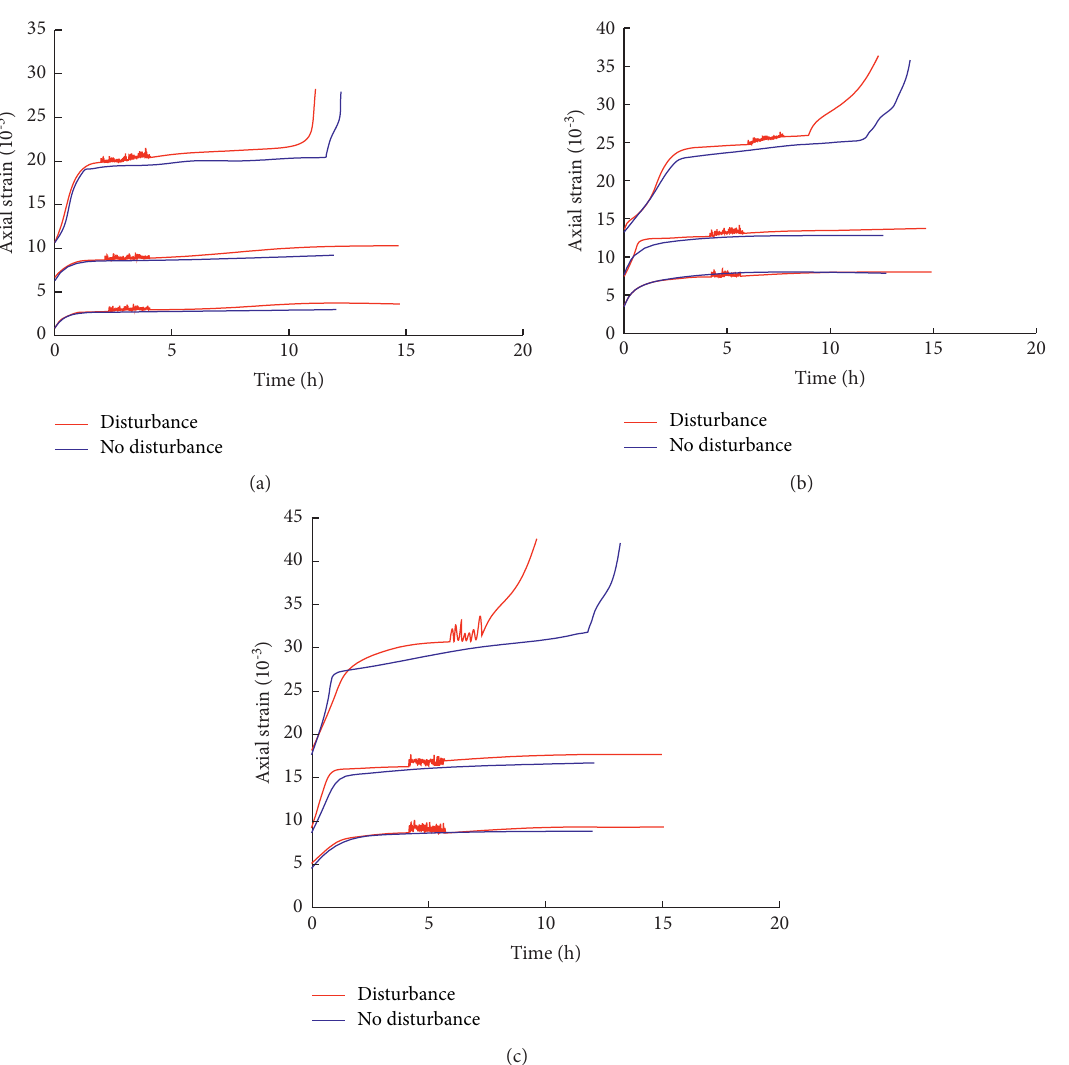
Figure 4: Creep disturbance curves for the mudstone specimens with different moisture contents: (a) ω � 0%; (b) ω � 5%; (c) ω �